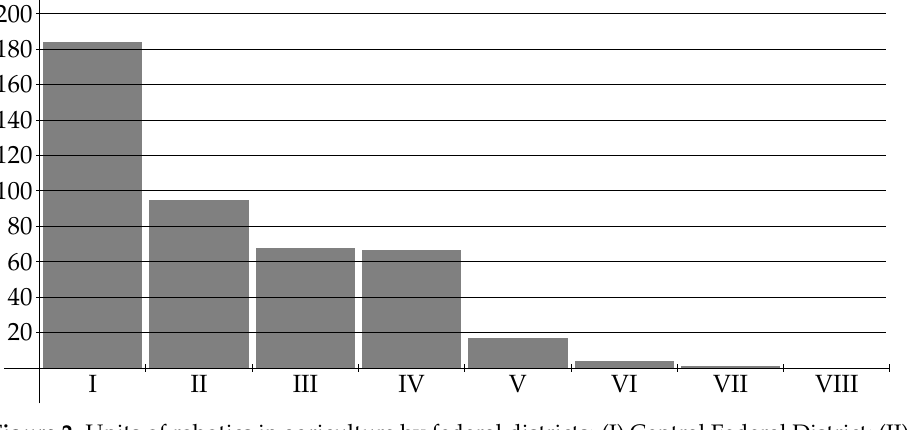
Figure 2. Units of robotics in agriculture by federal districts: (I) Central Federal District; (II) Volga Federal District; (III) Ural federal district; (IV) Northwestern Federal District; (V) Far Eastern Fed- eral District; (VI) Siberian Federal District; (VII) Southern Federal District; (VIII) North Caucasian Federal